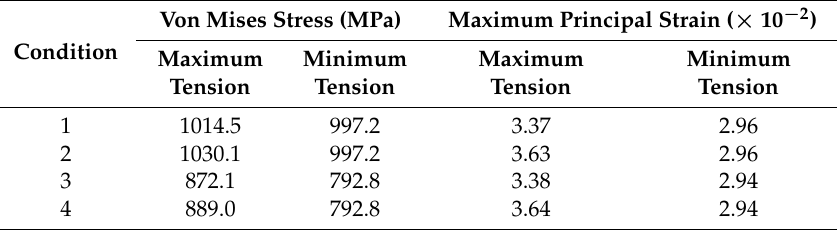
Table 8. Stress and strain results of the dangerous point for all conditions.